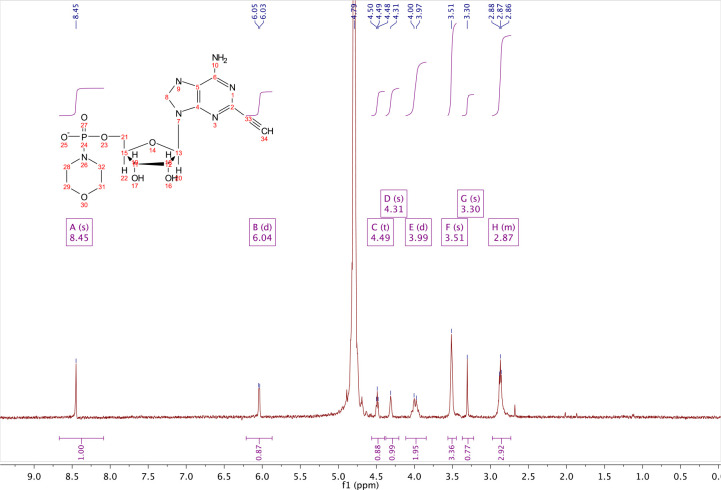
;1H NMR of compound 5.